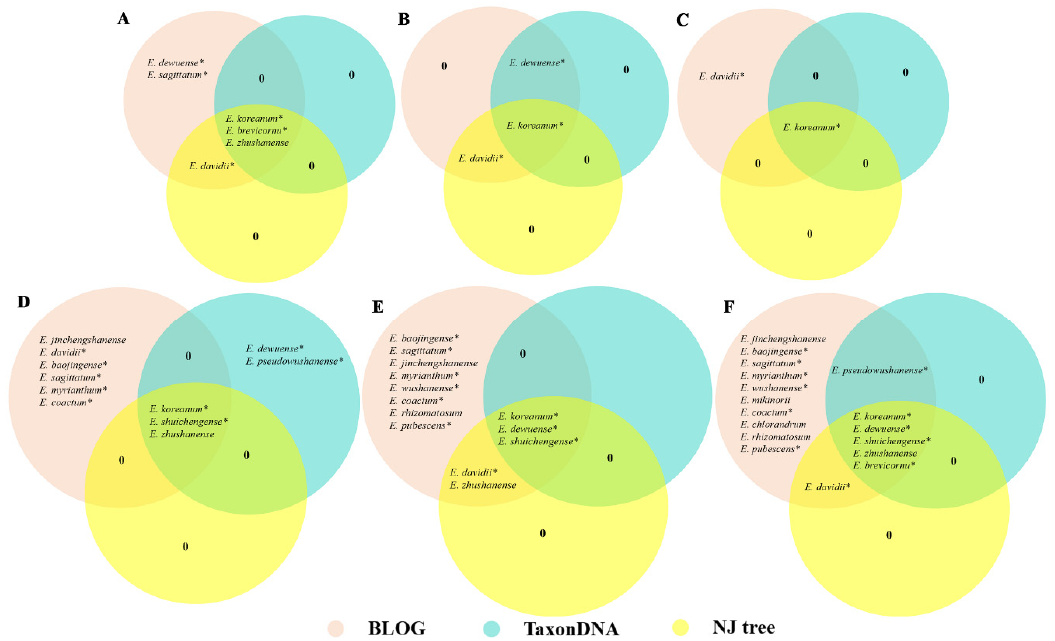
Figure 1. Species that can be identified based on three methods for each single locus and their combinations by using Venn diagrams. A, ITS; B, ITS2; C, rbcL ; D, psbA - trnH ; E, psbA - trnH + ITS2/ psbA - trnH + ITS2 + rbcL ; F, psbA - trnH + ITS/ psbA - trnH + ITS + rbcL. “*” represents medicinally used species.